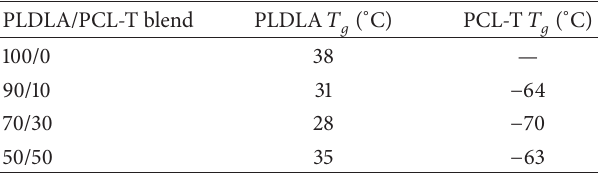
Table 1: The 𝑇 𝑔 temperatures for PLDLA/PCL-T membranes deter- mined by DMA based on the loss of modulus ( 𝐸 󸀠󸀠